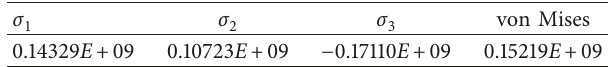
Table 3: The maximum principal stress and maximum von Mises stress of the wide girder